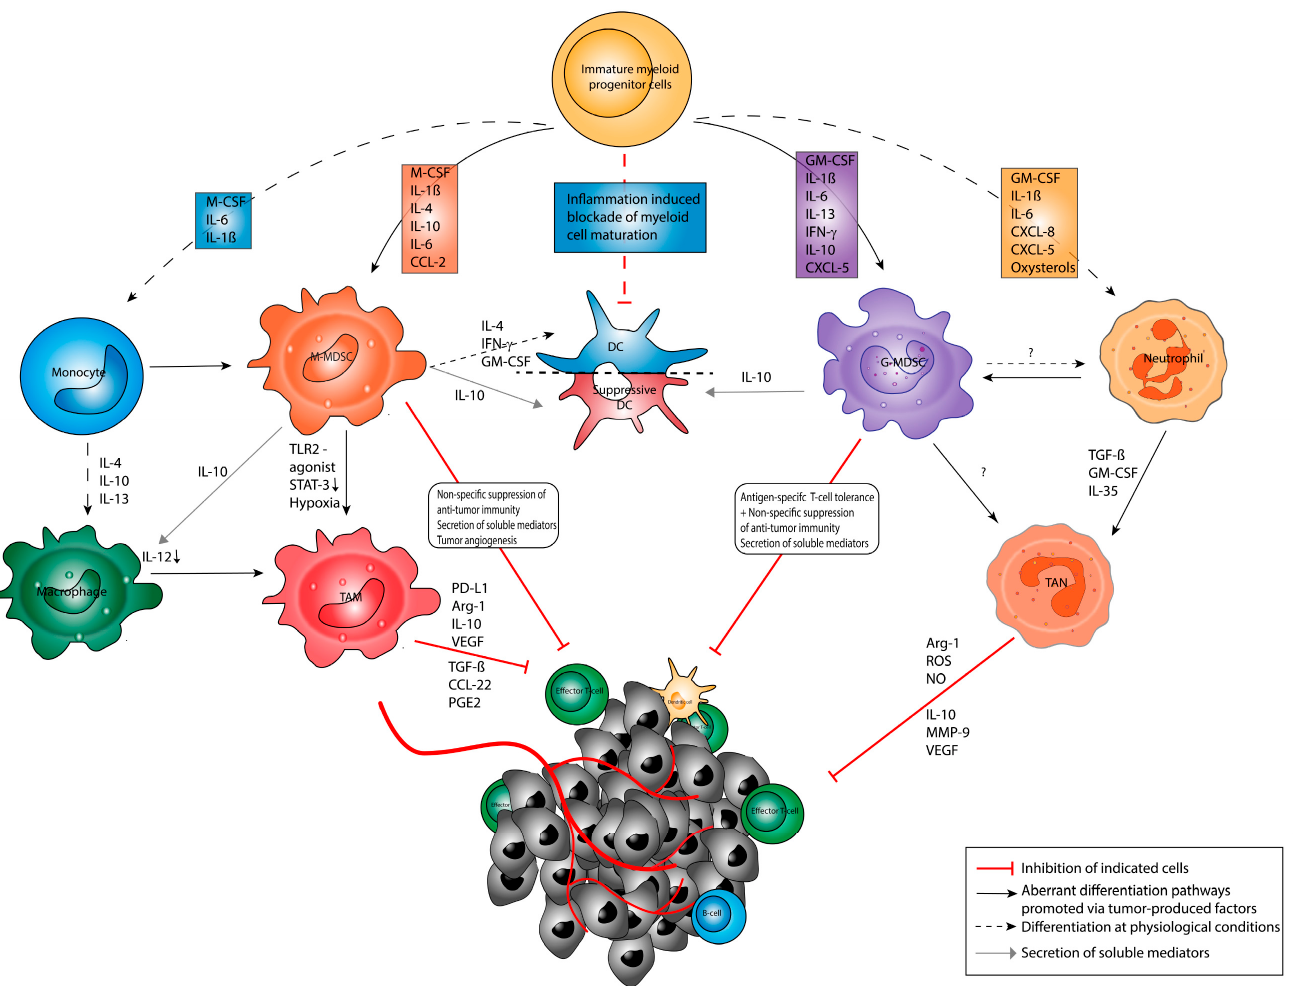
Figure 1. Myeloid cell plasticity in cancer. Myeloid cell types originate from hematopoietic stem cells and multipotent immature myeloid progenitor cells in the bone marrow (BM). The differentiation toward the matured cell line (i.e., polymorphonuclear neutrophils (PMN)) is promoted by soluble mediators and chemokines. In cancer patients, the differentiation pathways are strongly affected by factors produced in the tumor microenvironment (TME) by stromal cells, immune cells, and tumor cells (e.g., granulocyte-macrophage colony-stimulating factor (GM-CSF), interleukin (IL)-1 β , IL-6, IL-10, IL-23, interferon-gamma (IFN- γ )). In particular, the TME promotes the polarization of macrophages toward immunosuppressive tumor-associated macrophages (TAM), which confer the inhibition of effector T cells (Teff) within the TME via various mechanisms [72]. PMN within the TME frequently show a polarization toward immunosuppressive TAN, which is driven by soluble factors such as transforming growth factor- β (TGF- β ). Tumor-associated neutrophils (TAN) confer immunosuppression via multiple mechanisms. The most prominent effect of the aberrant differentiation includes the accumulation of granulocytic (G-MDSC) and monocytic (M-MDSC) myeloid-derived suppressor cells. Myeloid cells may act as an integrated system in the context of tumor immunity [49]. Depending on the structural composition of the TME, myeloid cells polarize from MDSC toward TAM or TAN or promote the tolerization of DC in the context of a nutrient-depleted, hypoxic, inflamed TME. Under normoxic conditions, IFN- γ and TNF- α have been found to reverse this polarization and promote MDSC differentiation toward immunogenic DC and inflammatory M1 macrophages. It remains questioned if MDSC and TAN undergo an irreversible polarization or can polarize to anti-tumor PMN